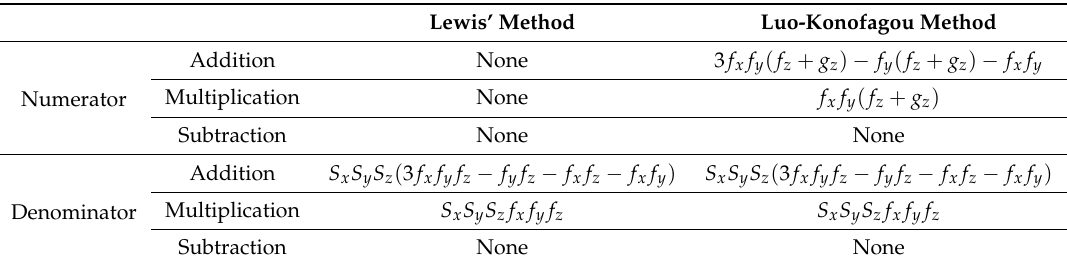
Table A2. A Summary of Algorithmic Complexity for Setting up Sum-tables needed for Lewis’ and Luo-Konofagou